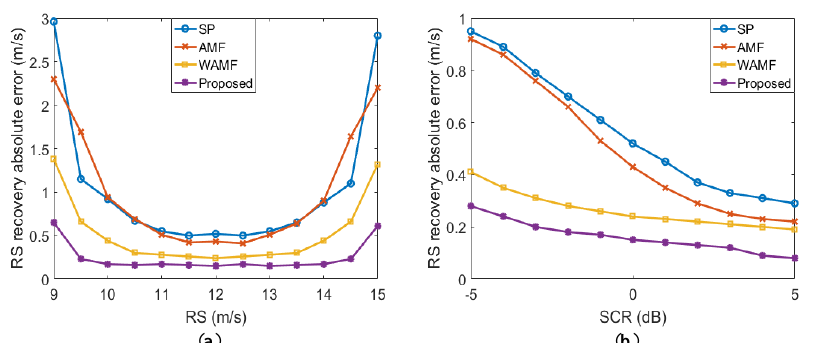
Figure 13. RS recovery results for different methods. ( a ) The absolute error of RS recovery versus RS. ( b ) The absolute error of RS recovery versus SCR.